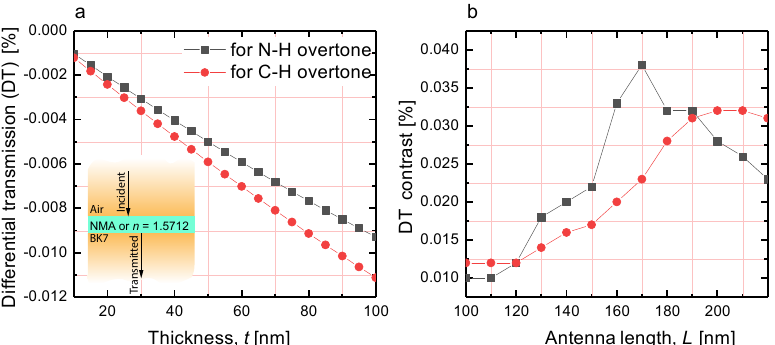
Figure 6. ( a ) DT of NMA films on a bare substrate as function of the film thickness. The insert shows the structure of the parallel films used for the calculation under the normal incidence illumination. ( b ) The DT contrast estimated from the data presented in Figure 5 as a function of the nanoantenna